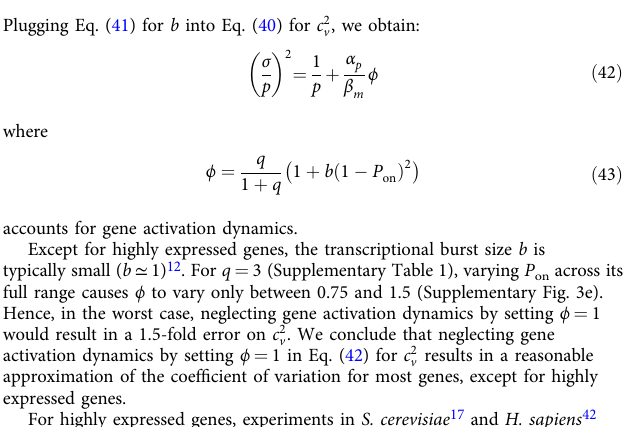
where α p is the protein decay rate and c v 0 is the noise fl oor due to extrinsic noise 40 or the larger transcriptional burst size of high abundance proteins 42 (see previous section). We can now solve for the β m that maximizes fi tness, by fi nding d F h i The optimal translation/transcription ratio rate β p / β m satis fi es